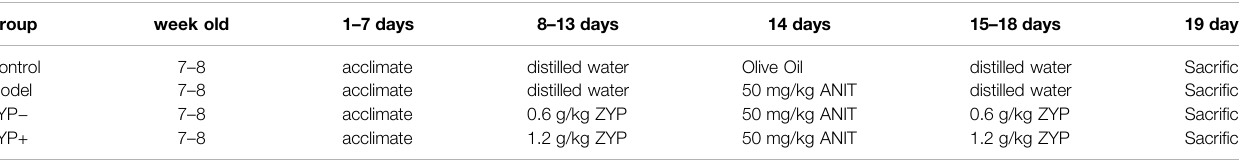
TABLE 1 | The schematic diagram of the animal experimental design.